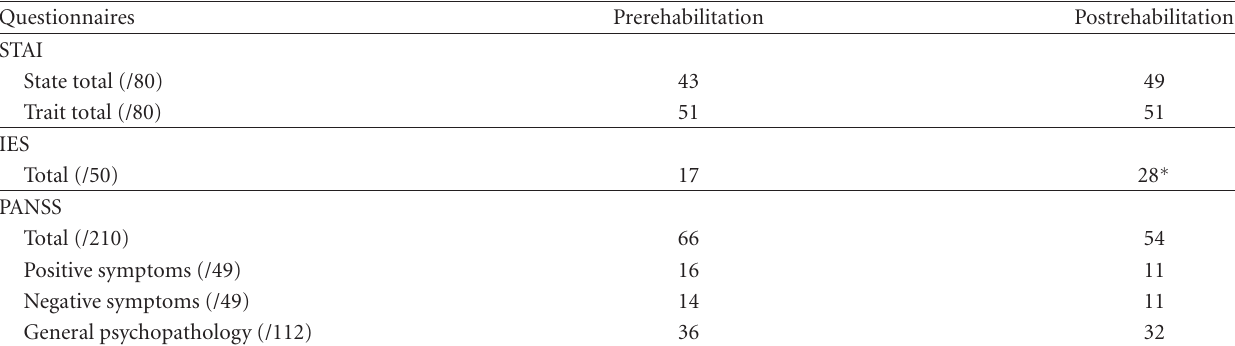
Table 6: G. O.’s results on the subjective